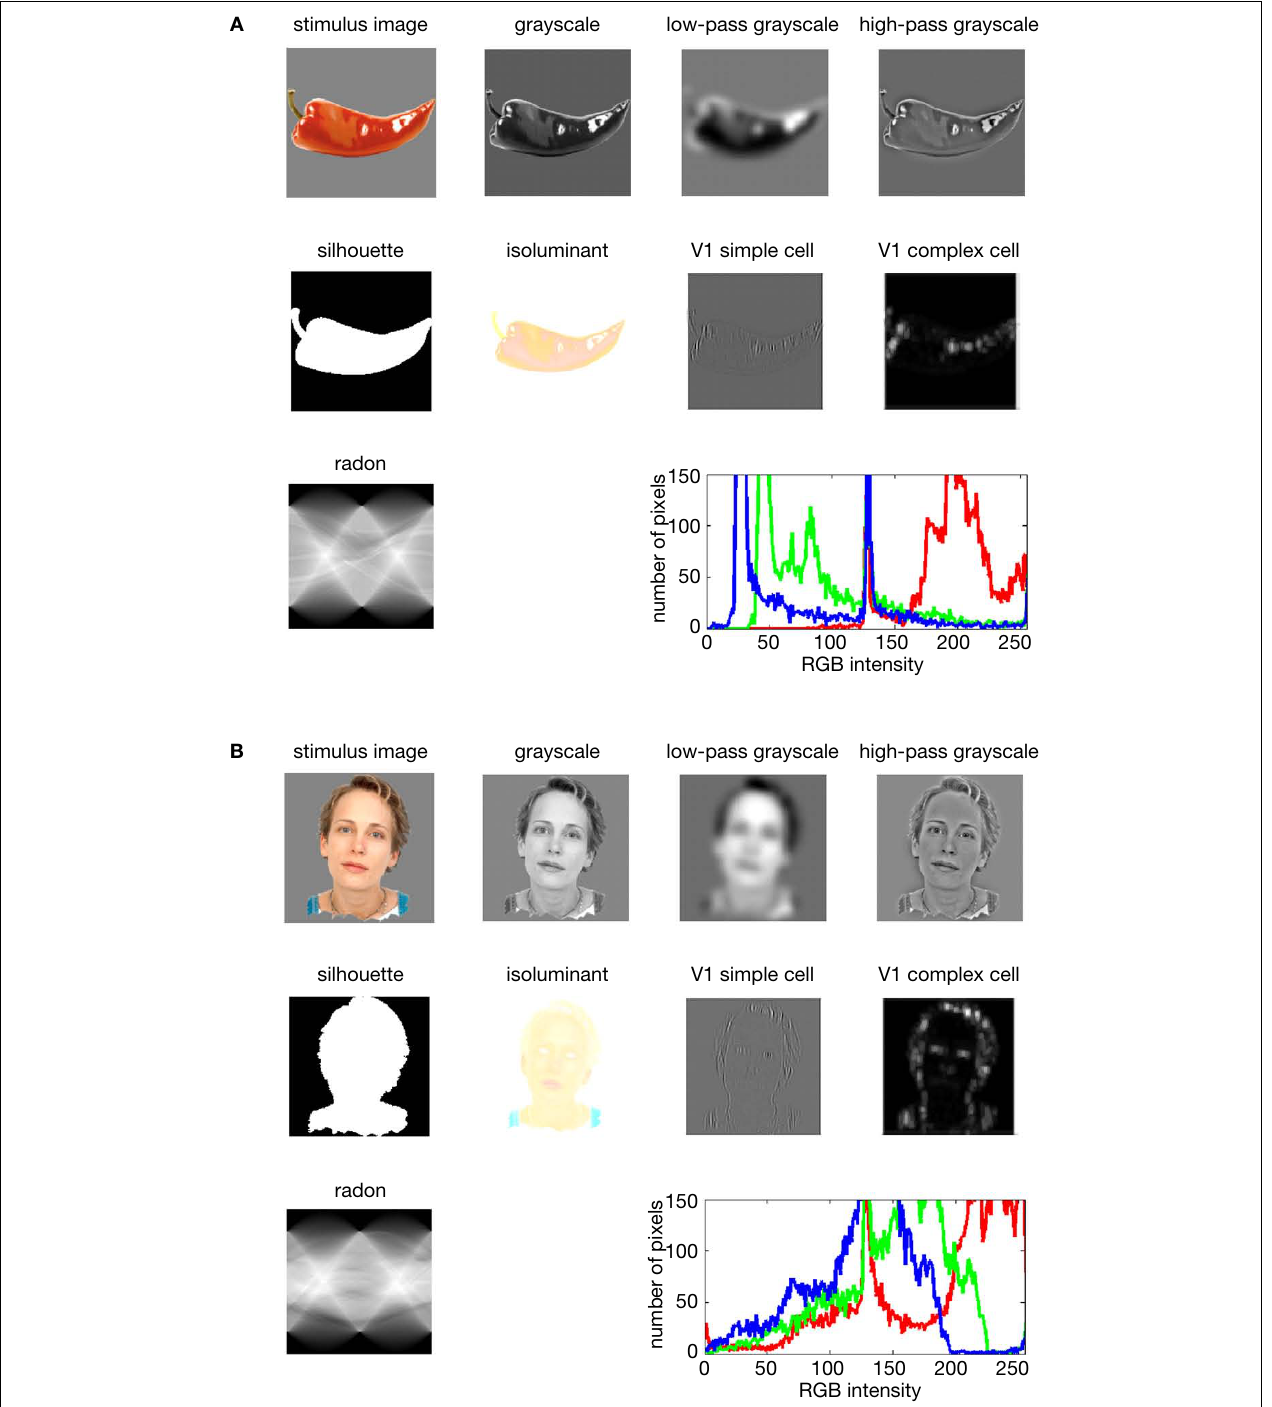
FIGURE 5 | Model representations of two example images . Two example images (A,B) from the 96-image experiment and their representations in a number of computational models, including standard transformations of image